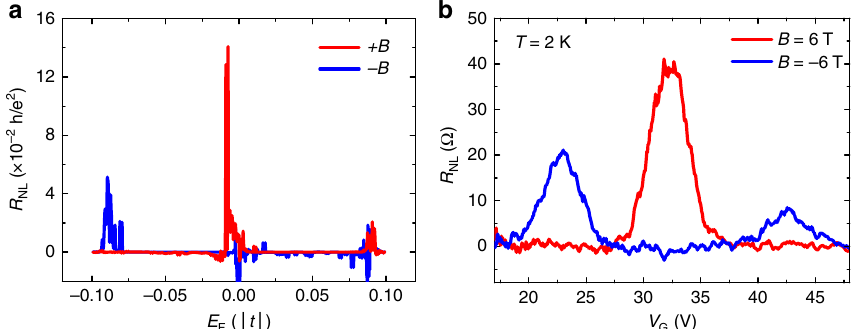
Fig. 5 Nonlocal resistance dependence with magnetic fi eld direction in a graphene Hall bar device. a Tight-binding simulation in the nonlocal geometry with a single 558-type line defect connecting the edges of a Hall-bar graphene channel. Nonlocal signals vs. position of the Fermi level relative to the CNP for opposite directions of the applied perpendicular magnetic fi eld. b Nonlocal resistance as a function of back-gate voltage for a 5- μ m-wide and 16- μ m-long graphene Hall bar at 2 K for opposite directions of the applied perpendicular magnetic fi